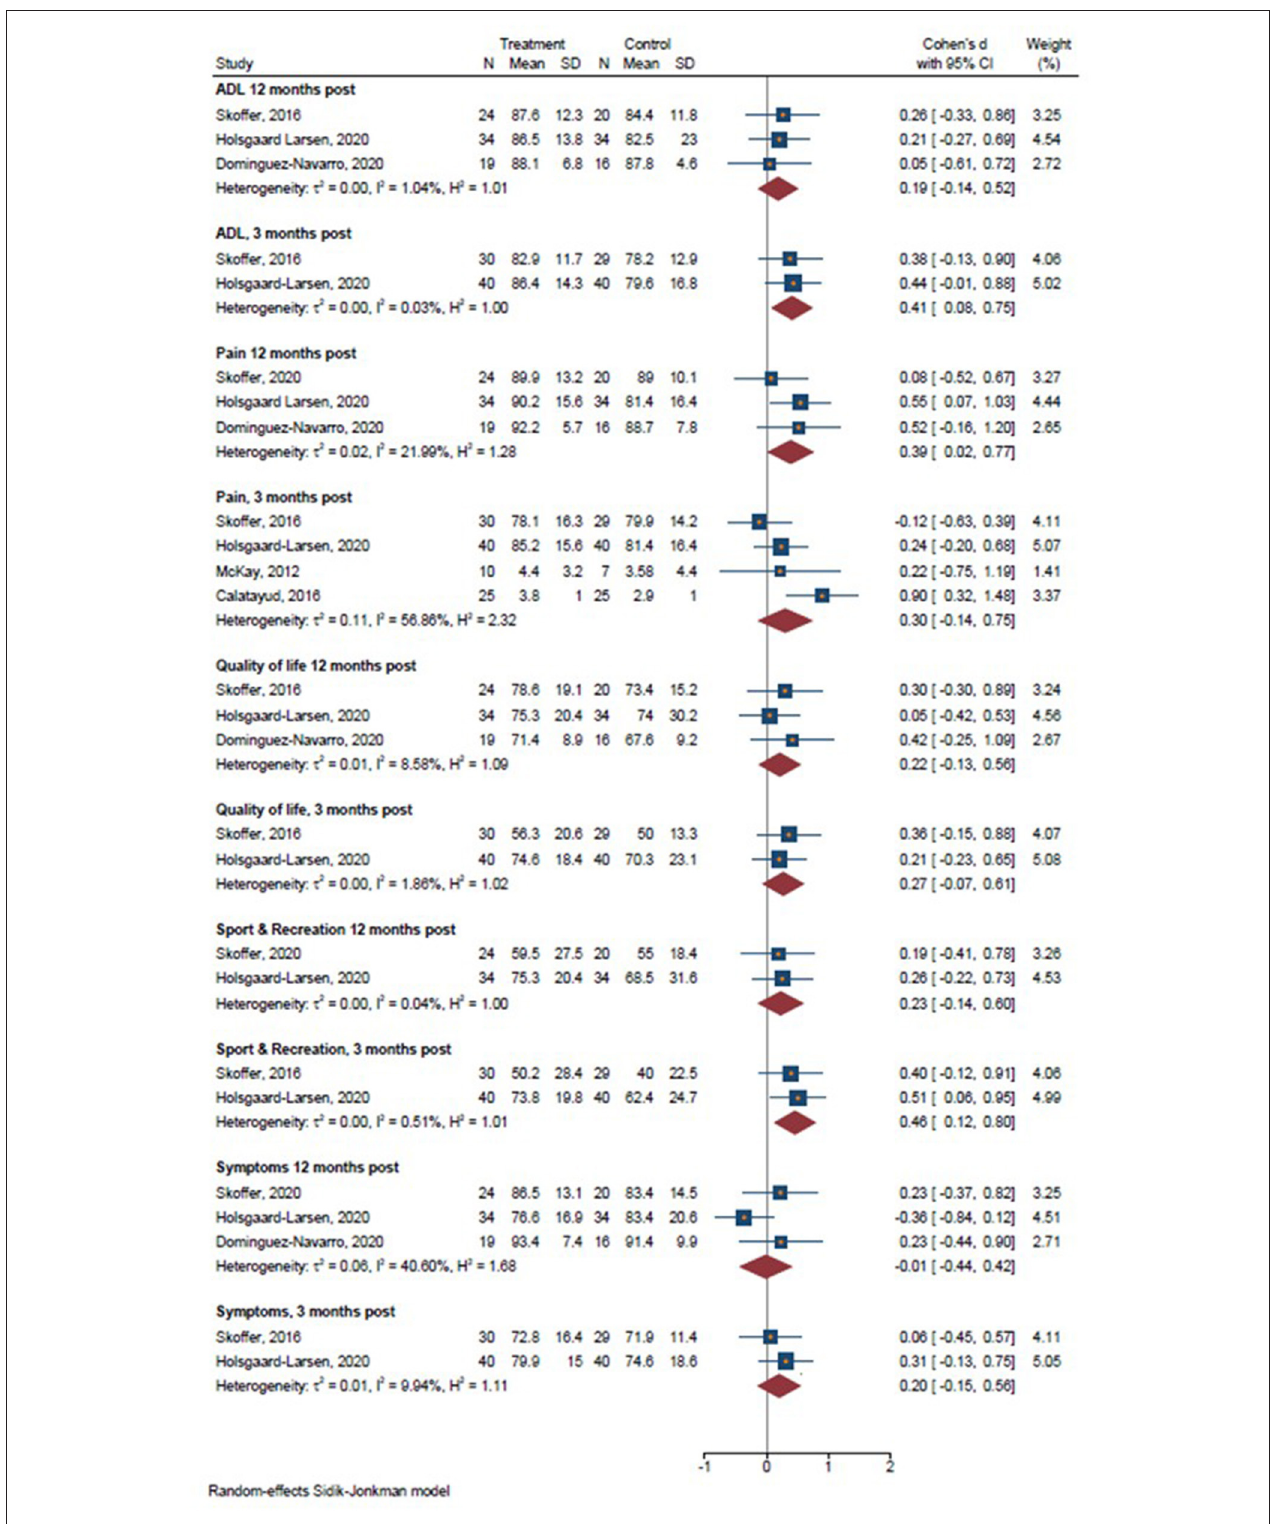
FIGURE 5 | Forrest plots on patient-reported outcomes 3 and 12 months post-operatively. Forest plots of the results of a random-effects meta-analysis shown as standardized mean differences with 95% CIs on patient-reported outcomes 3 and 12 months post-operatively. For each study, the blue square represents the point estimate of the intervention effect. The horizontal line joins the lower and upper limits of the 95% CI of this effect. The green diamonds represent the pooled mean difference for each outcome.